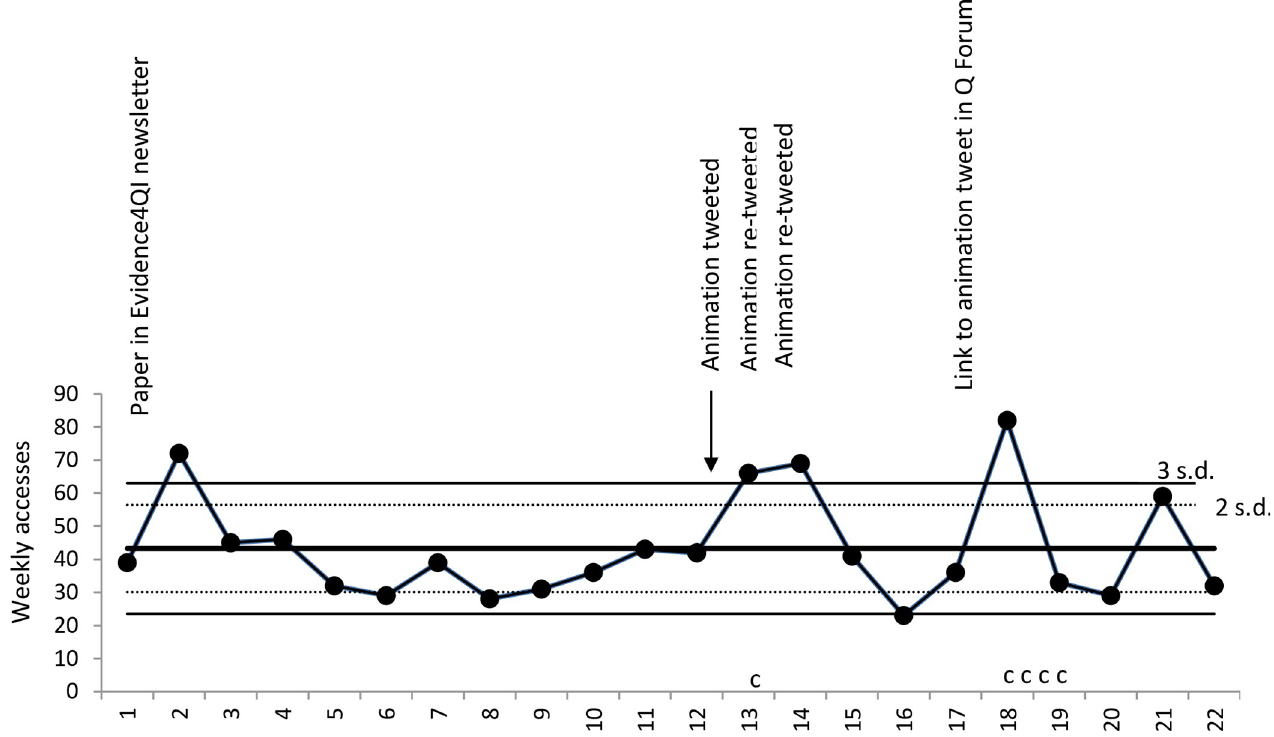
Fig 3. A statistical process control c-chart showing weekly accesses of Sykes et al. (2021) and numbers of contacts [c] made to first author by stakeholders.